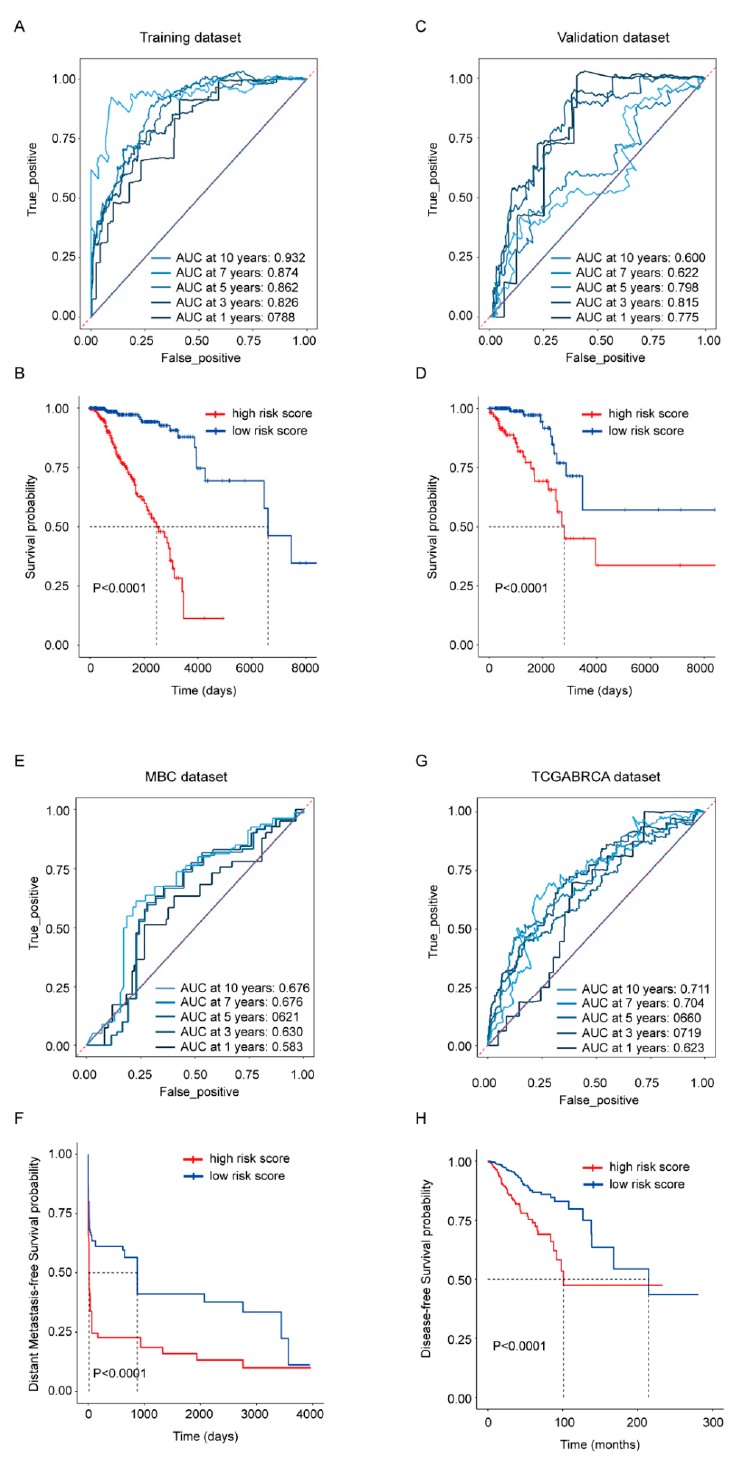
Figure 3. Prognostic performance of the 45-gene signature. ( A , C ) Time-dependent ROC curves with AUCs at 1-, 3-, 5-, 7- and 10-year OS based on the gene signature in the TCGA-BRCA training ( A ) and validation ( C ) cohorts separately. ( B , D ) Kaplan–Meier plots of OS in subgroups with different risk scores in the training ( B ) and validation ( D ) cohorts separately. ( E ) Time-dependent ROC curves with AUCs at 1-, 3-, 5-, 7- and 10-year distant metastasis-free survival in MBC cohort. ( F ) Kaplan–Meier plots of distant metastasis-free survival in MBC cohort. ( G ) Time-dependent ROC curves with AUCs at 1-, 3-, 5-, 7- and 10-year disease-free survival in whole TCGA-BRCA cohort. ( H ) Kaplan–Meier plots of disease-free survival in whole TCGA-BRCA